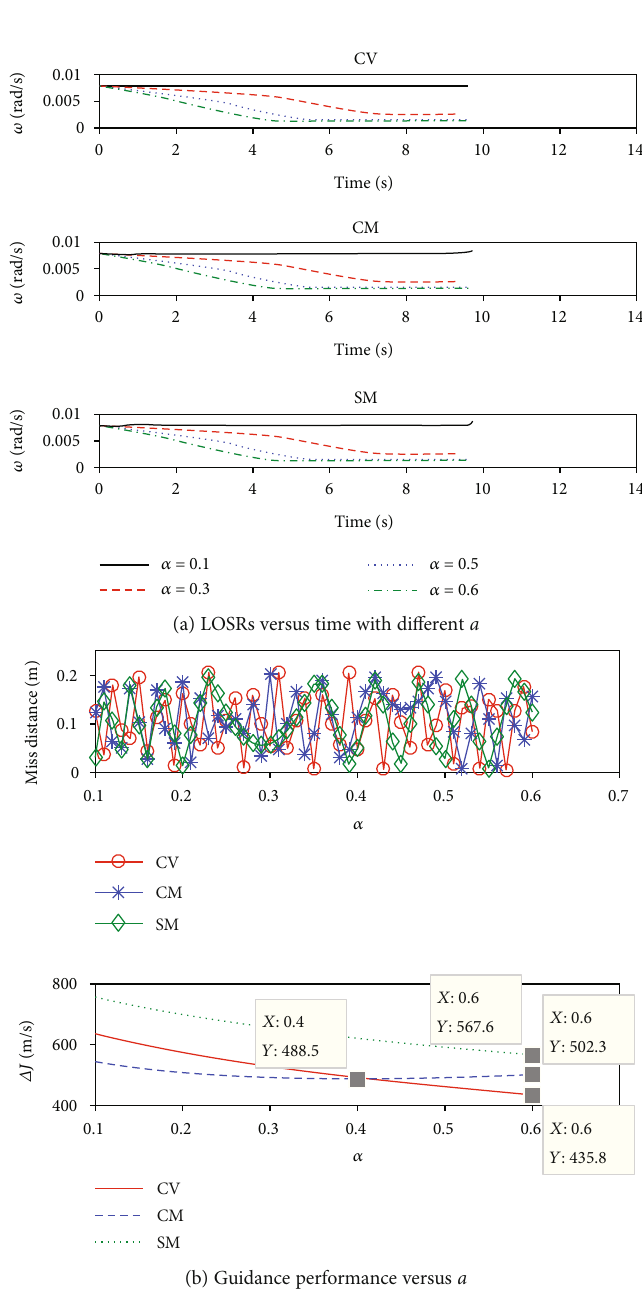
Figure 9: Intercept characteristics with pro fi le parameter — Case Figure 10. The RMS values of the results are summarized in Table 7. It can be seen that the performance of PTB-AGL is satisfactory in the Monte Carlo sense, and largely better than that of OE-FTC-GL when intercepting the SM target.